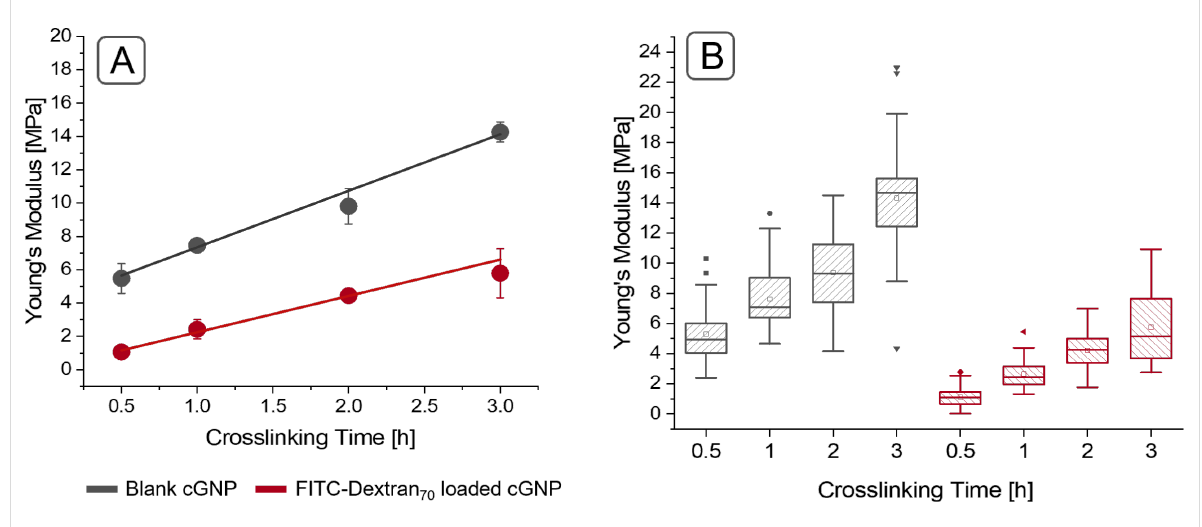
Figure 2: Young’s moduli of gelatin nanoparticles and crosslinking time. (A) Highlighting the linear dependency of crosslinking time and the resulting mechanical properties. Using the mean Young’s modulus of each batch to calculate the overall mean of each respective formulation. Unloaded parti- cles in grey and particles loaded with FITC-dextran 70 kDa in red. (B) Showing the distribution of Young’s moduli by plotting boxplots with all mea- surement values. Looking at the Young’s moduli after the tested crosslinking times as well as comparing loaded particles with blank gelatin nanoparti- cles of the same crosslinking time, the difference of the resulting mechanical properties is statistically